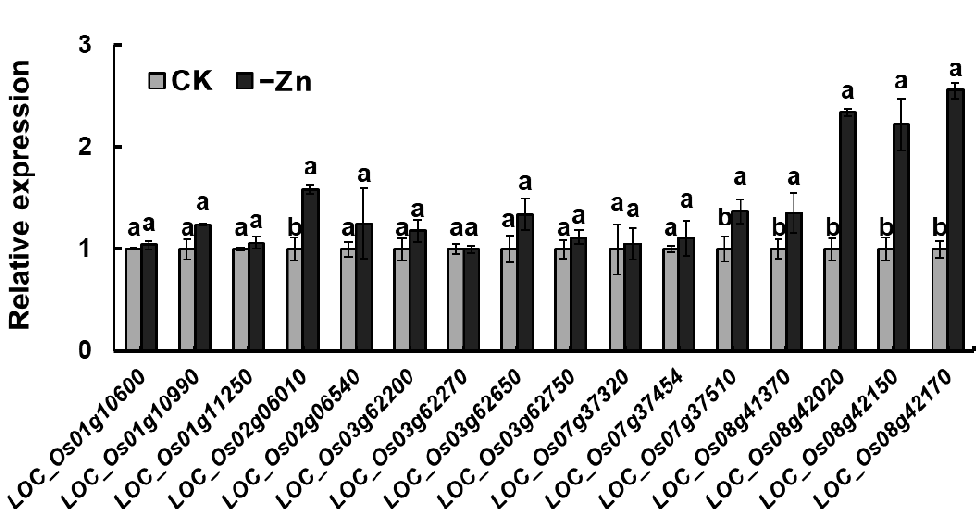
Figure 4. Relative expression of 16 candidate genes under different Zn 2+ concentrations. The seedlings of rice cv. Nipponbare at the three-leaf stage grown in 1/4 strength IRRI solution with 0.77 µ M Zn 2+ (CK) or without Zn 2+ ( − Zn) for three weeks were used. RNA was extracted from rice roots. Values are mean ± SE (n = 3). The different letters above the bars indicate significant difference between the control and treatments at p < 0.01.